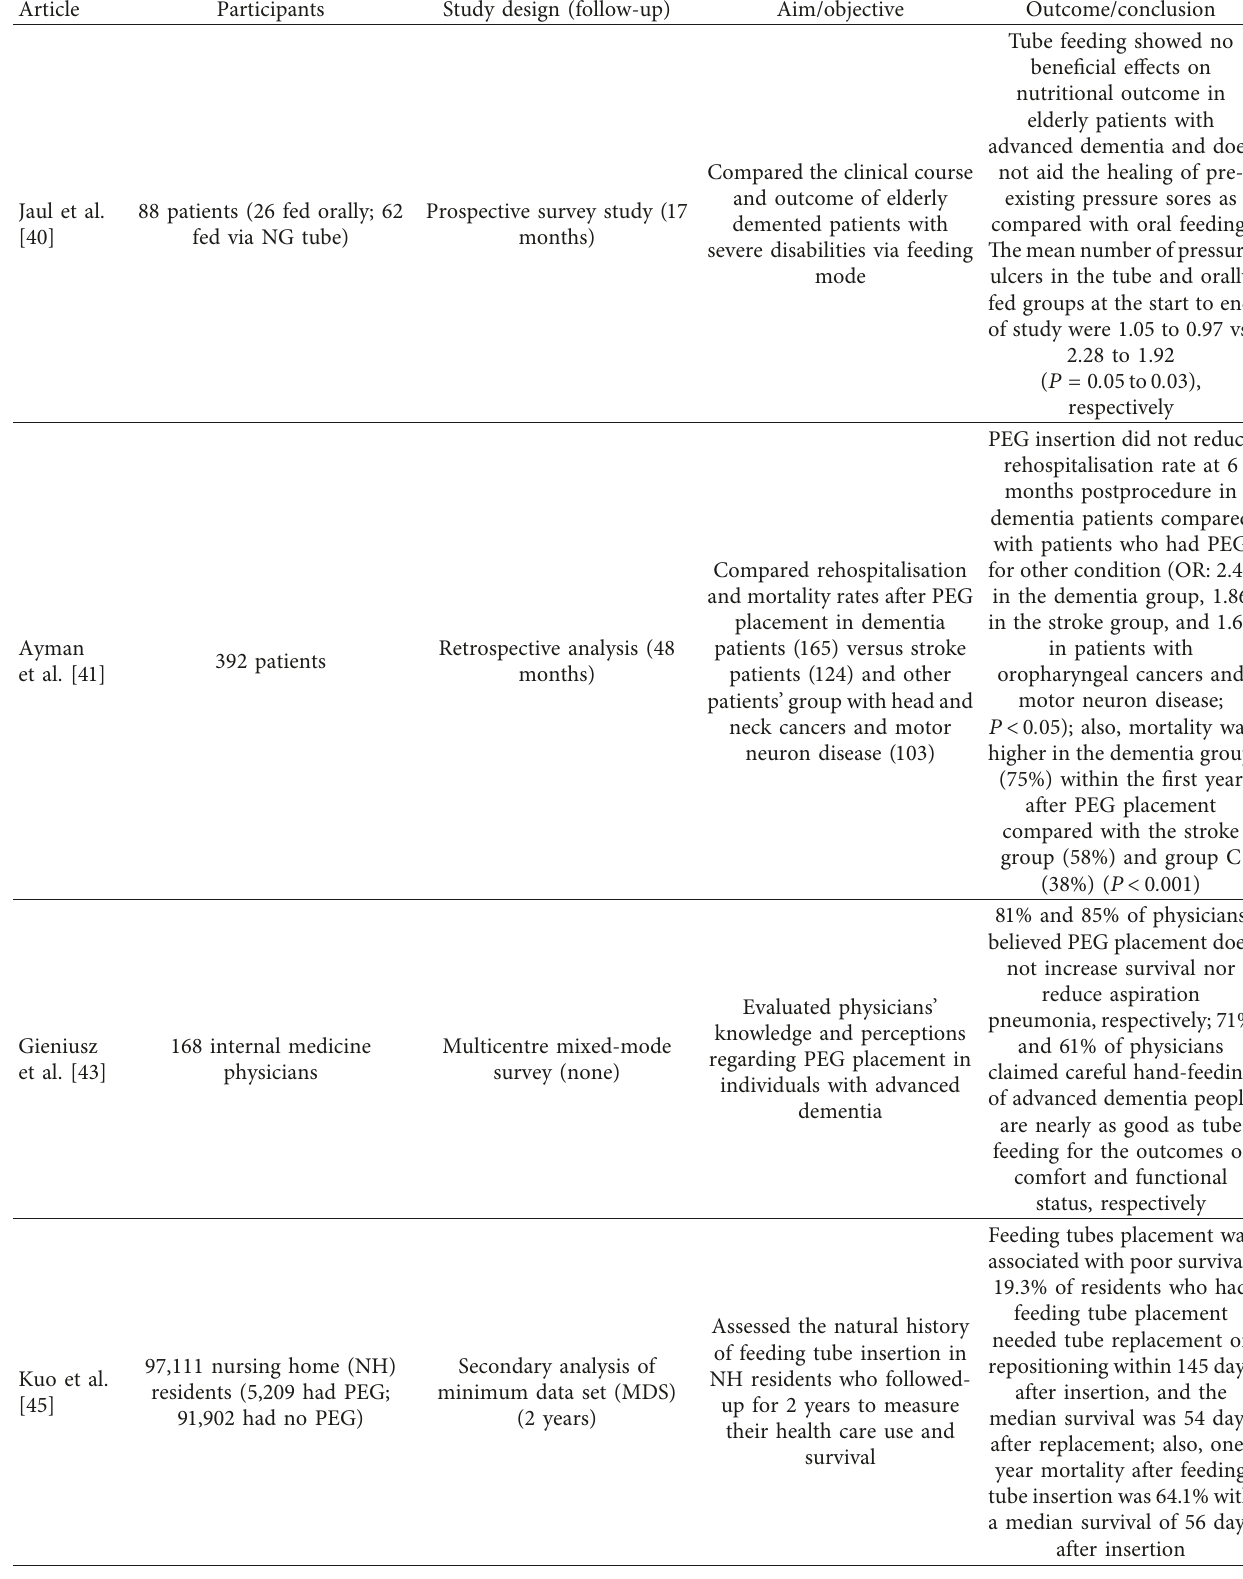
Table 1: Summary of studies on the burdens of tube feeding in individuals with advanced